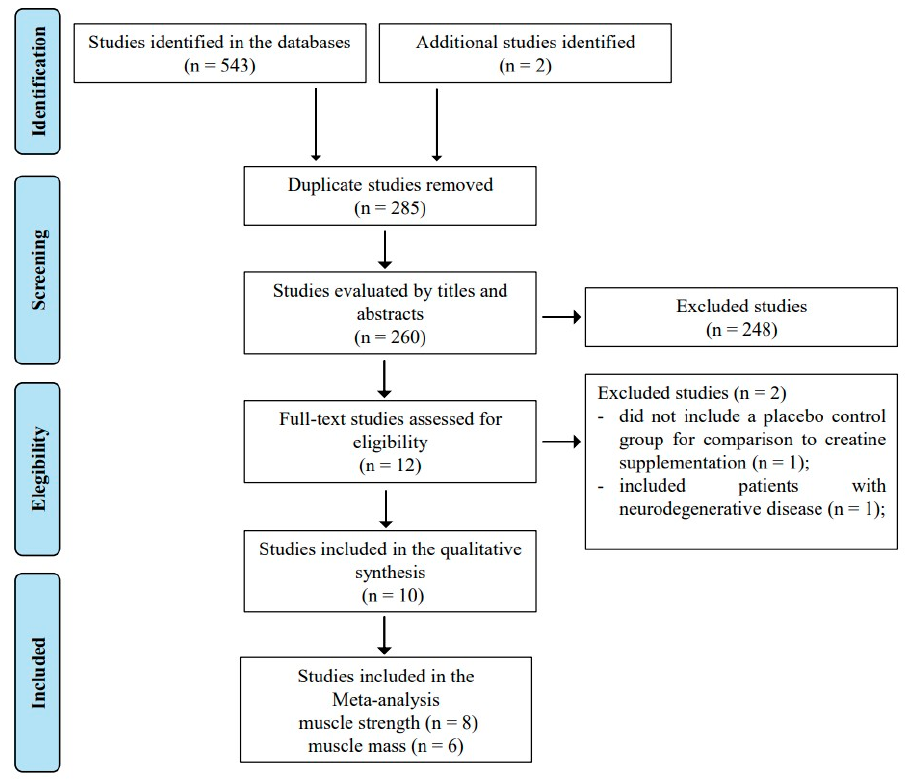
Figure 1. Flowchart of the study selection process.